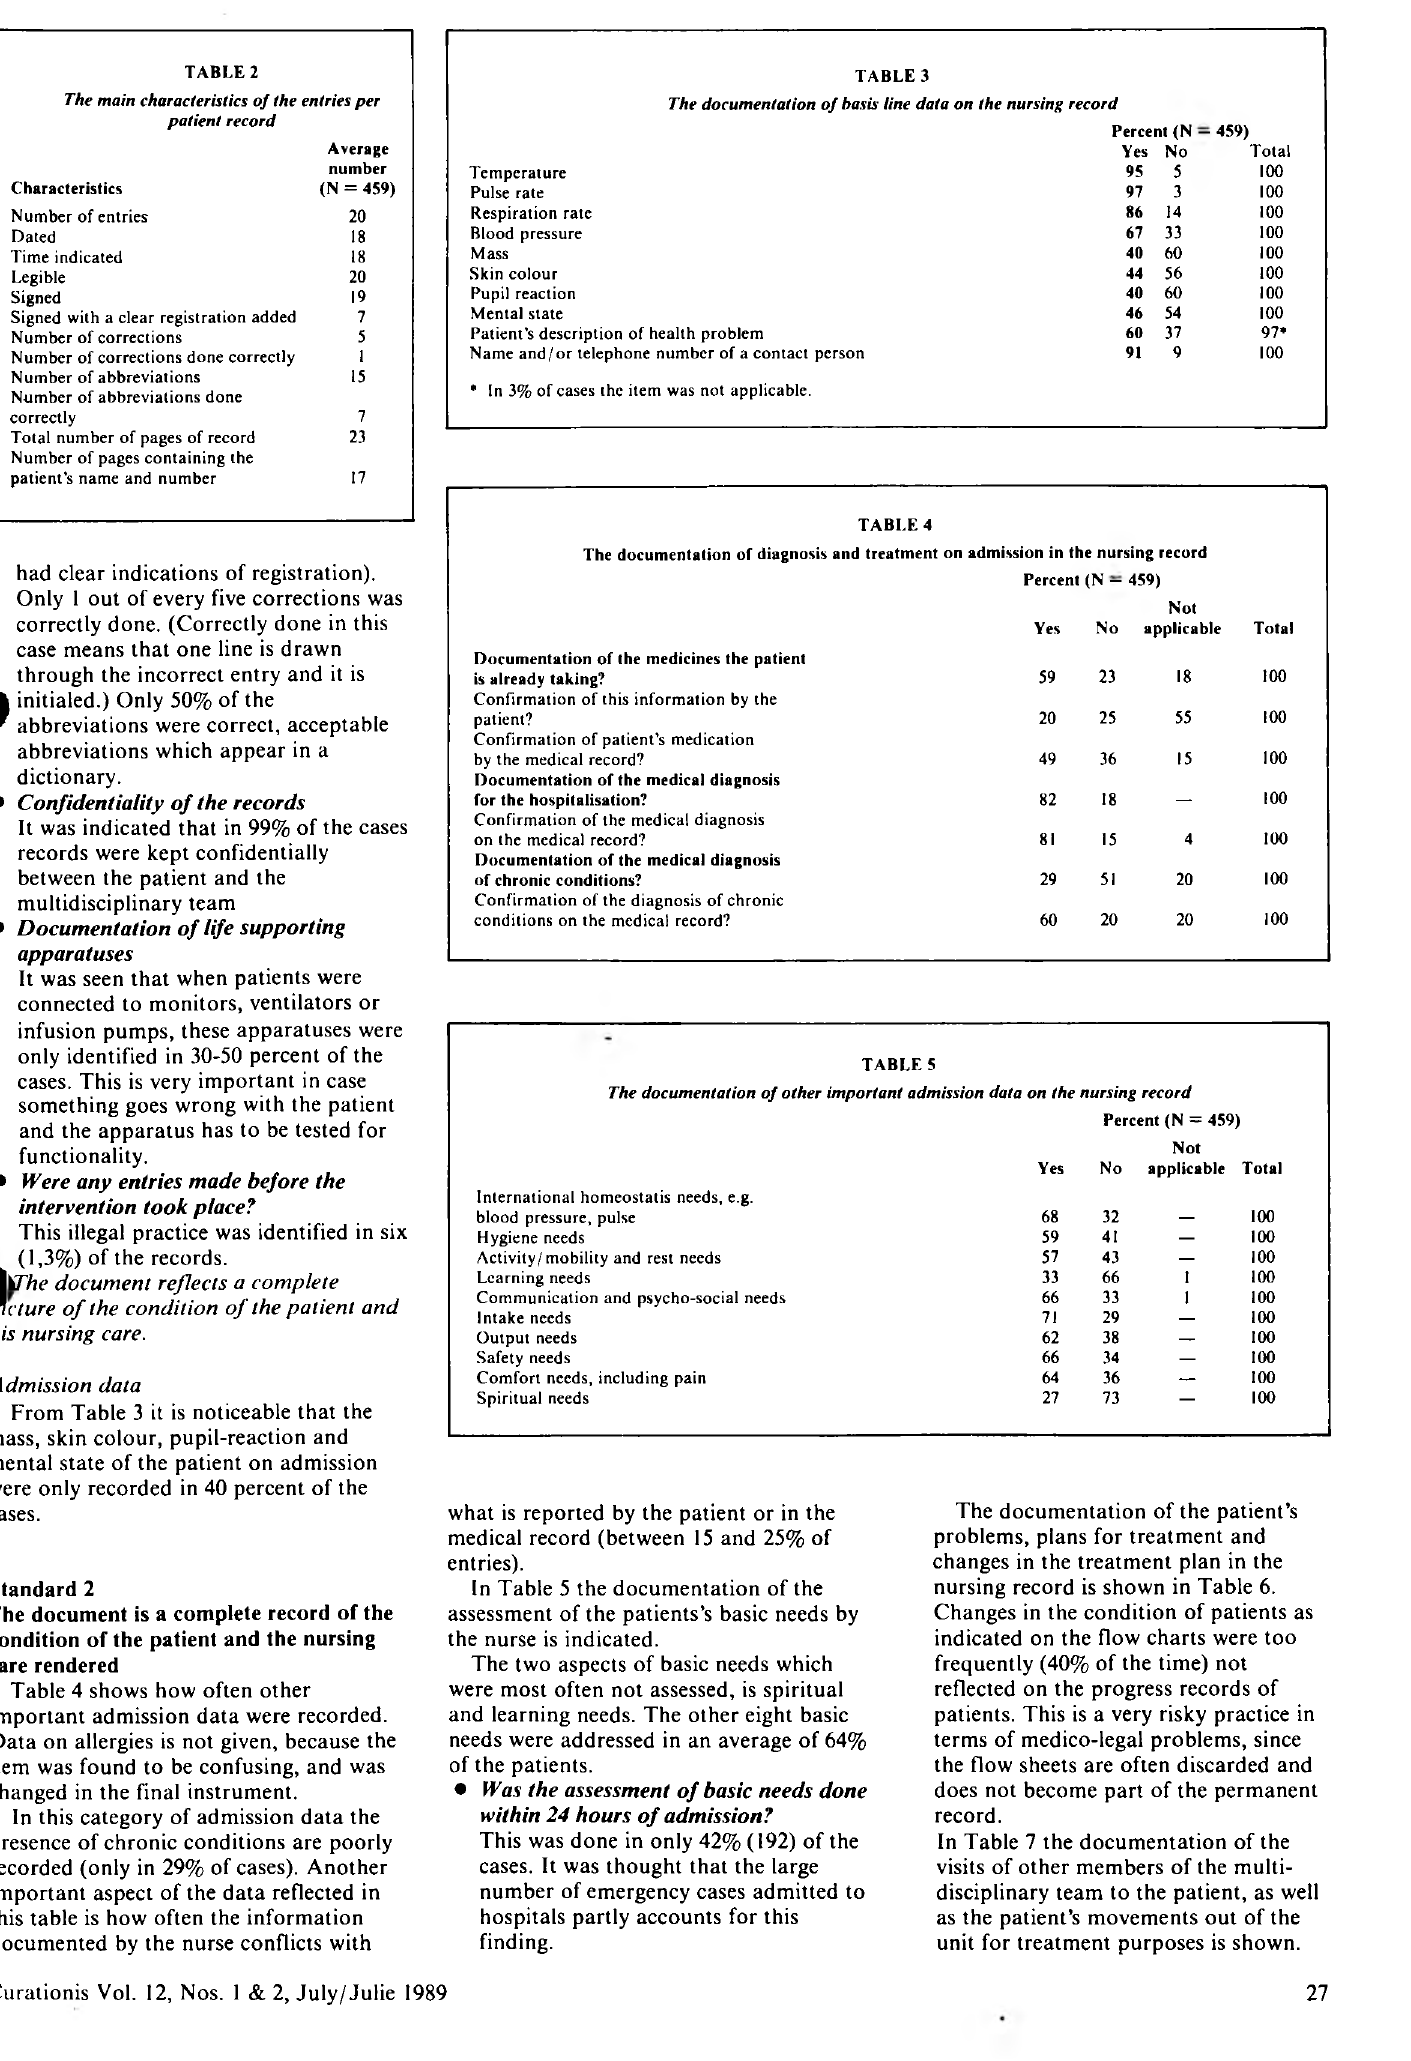
The documentation of basis tine data on the nursing